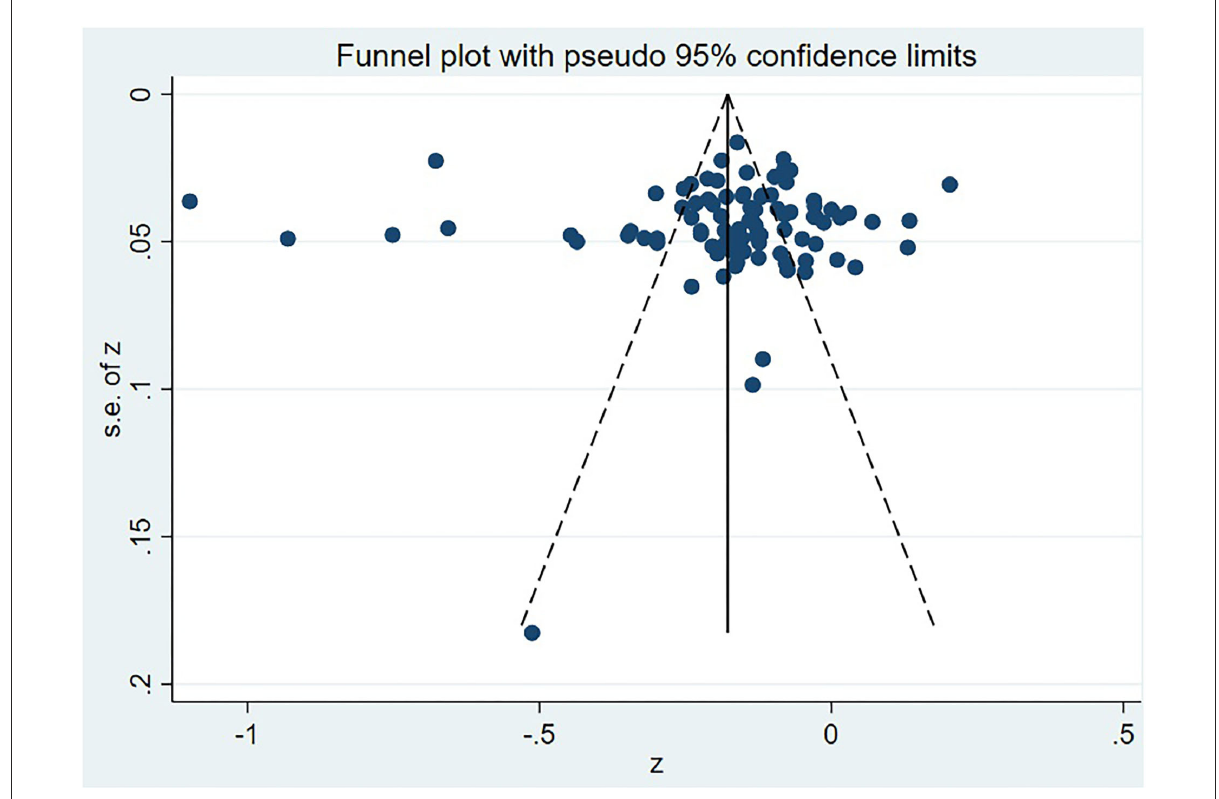
FIGURE2 Funnel plot of the association of mobile phone addiction and social